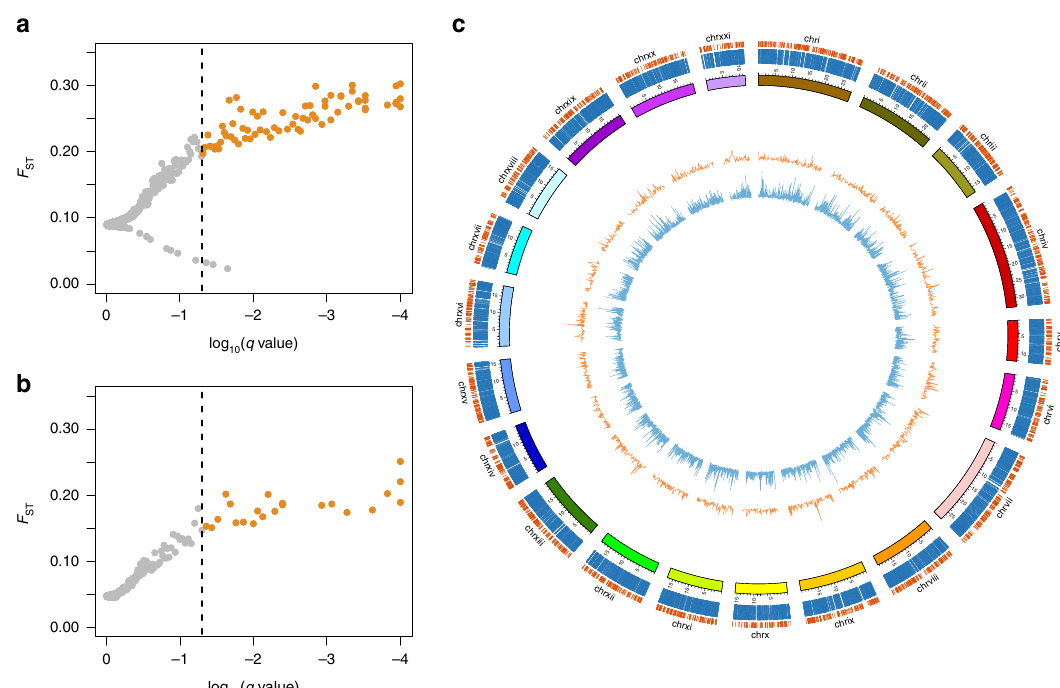
Fig. 2 Genomic population divergence in eight coexisting populations of the three-spined and nine-spined stickleback. BAYESCAN outlier detection in data sets containing a 12,754 SNPs for the three-spined and b 10,090 SNPs for the nine-spined stickleback. Genetic divergence ( F ST ) of each locus is plotted against the log-transformed q value. Loci in orange are classi fi ed as candidates under divergent selection. Loci in grey are classi fi ed as neutral or are candidates under balancing selection. c Map of the three-spined stickleback genome. The outermost ( orange ) and second outermost ( blue ) bars represent the mapped genotyped loci in the nine-spined and the three-spined stickleback, respectively. The coloured blocks represent the different linkage groups. The orange (nine-spined stickleback) and blue (three-spined stickleback) inner circles represent line charts showing F ST for all SNPs throughout the